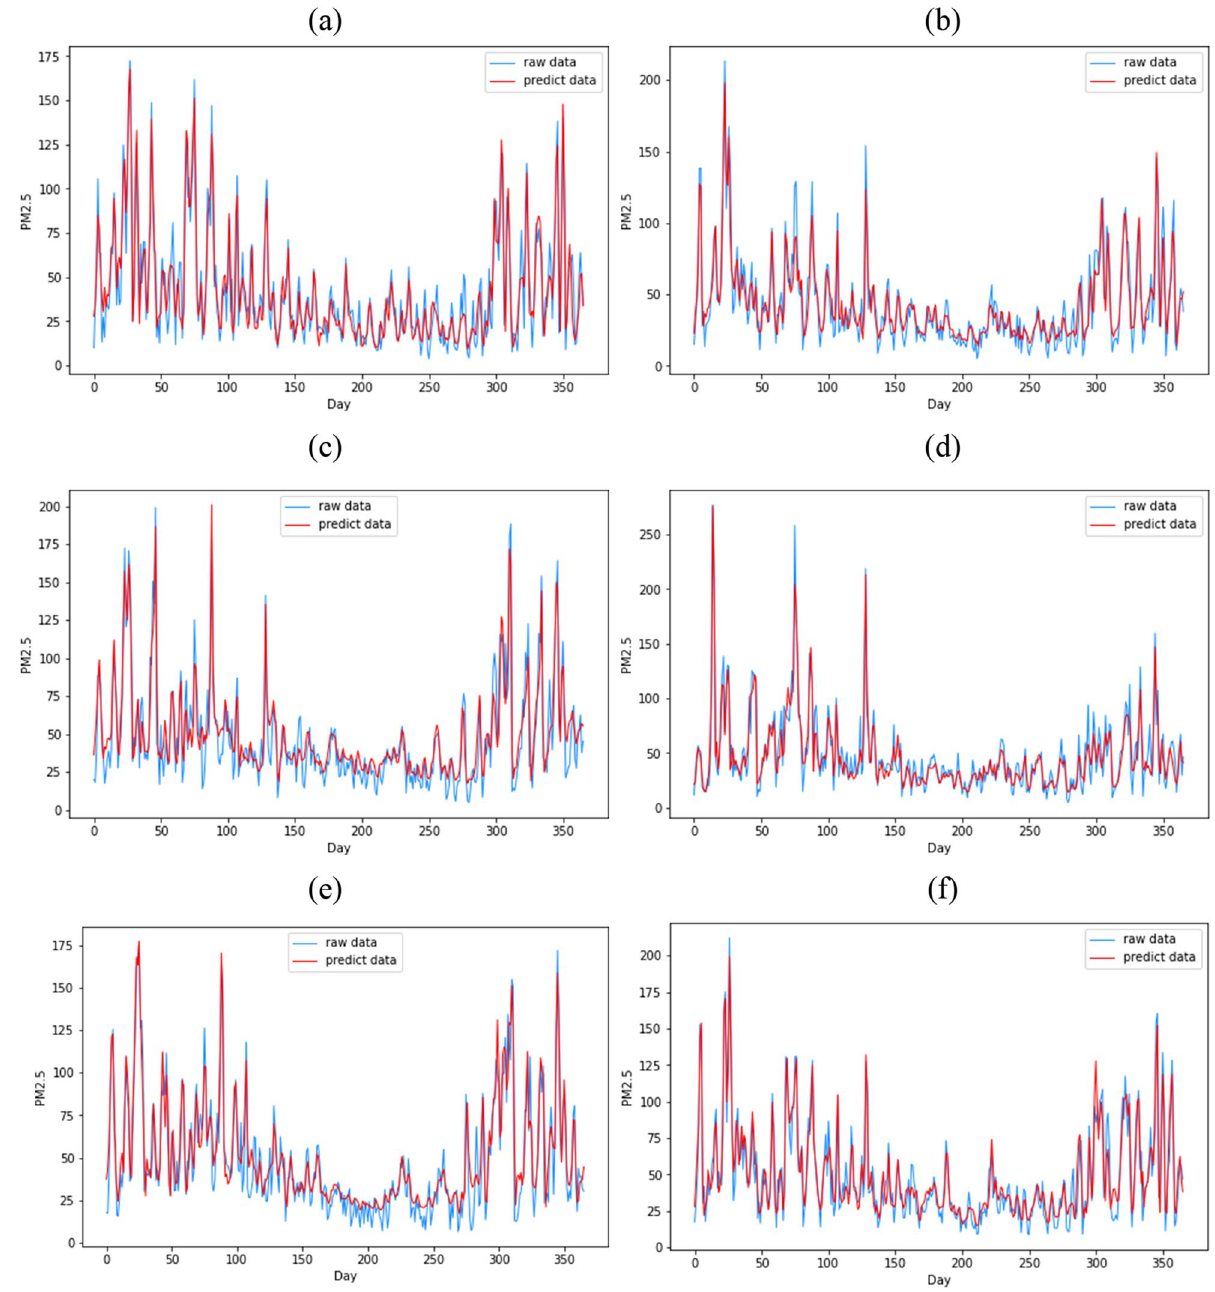
Figure 6. PM2.5 forecast curve for the six cities. (μg/m 3 ). ( a ) Binzhou, ( b ) Jinan, ( c ) Handan, ( d ) Taiyuan, ( e ) Xinxiang and ( f )